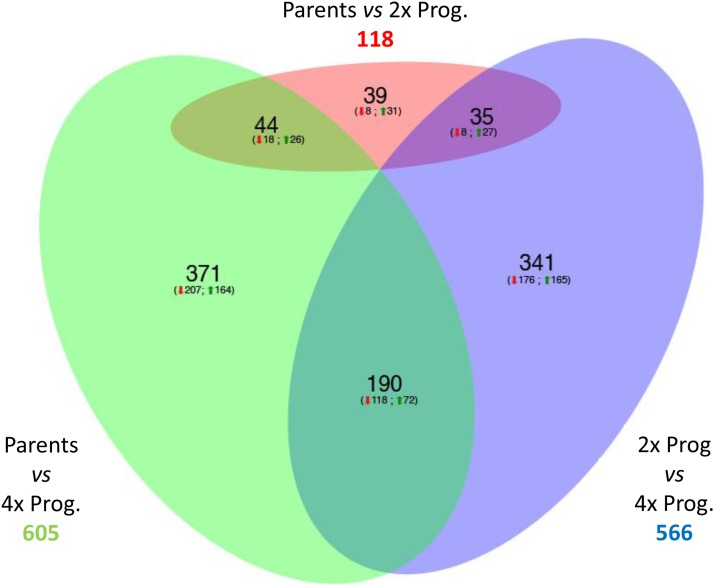
Venn diagram summarizing the results of the microarray experiment. Pink: genes differing in transcription level between the parents and the 2x progeny (Hybridization-sensitive, HS). Green: genes differing between the parents and the 4x hybrids (Hybridization and Polyploidization sensitive, HPS). Blue: genes differing between the 2x and the 4x hybrids (Polyploidization sensitive, PS). The red arrows refer to subset of genes that are underexpressed in the former group of each comparison, while the green arrows refer to the subset of genes that are overexpressed in the former group of each comparison.